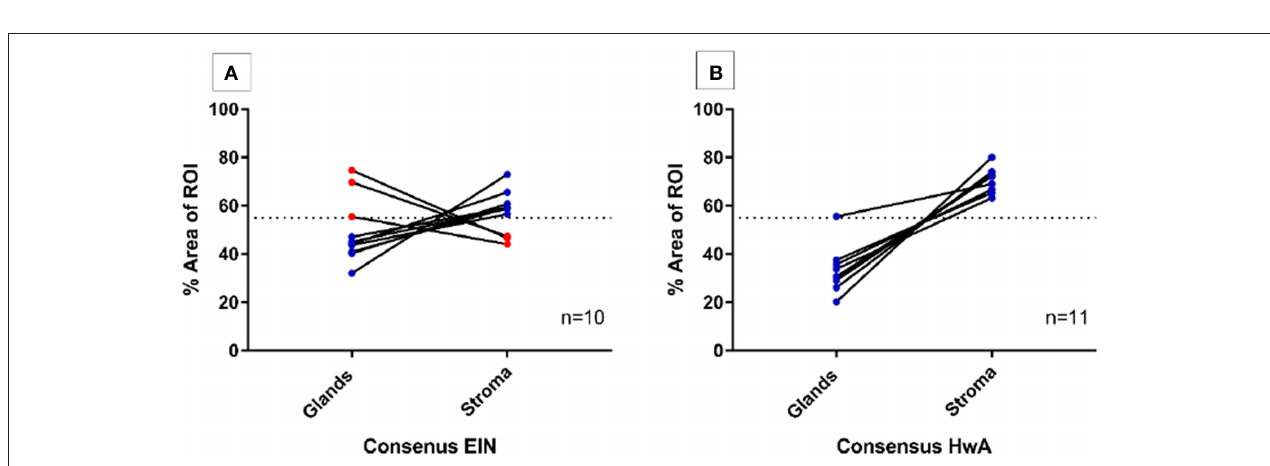
FIGURE 3 | Semi-automated quantitative image analysis reveals differences between the final consensus pathology diagnosis and the EIN diagnostic criteria. Dashed line represents the 55% threshold for volume percentage stroma (VPS) that is considered diagnostic. (A) 3/10 (red) cases with a final consensus diagnosis of EIN met the EIN diagnostic criteria for architecture with a VPS of < 55%, meaning that the glandular epithelial compartment exceeded that of the stromal compartment within the ROI. The remaining 7/10 cases (blue) do not show image analysis evidence of EIN using the architectural definition of a VPS < 55%. (B) All final consensus diagnoses of HwA were correctly found to have stromal areas that exceeded that of the glands by image analysis.